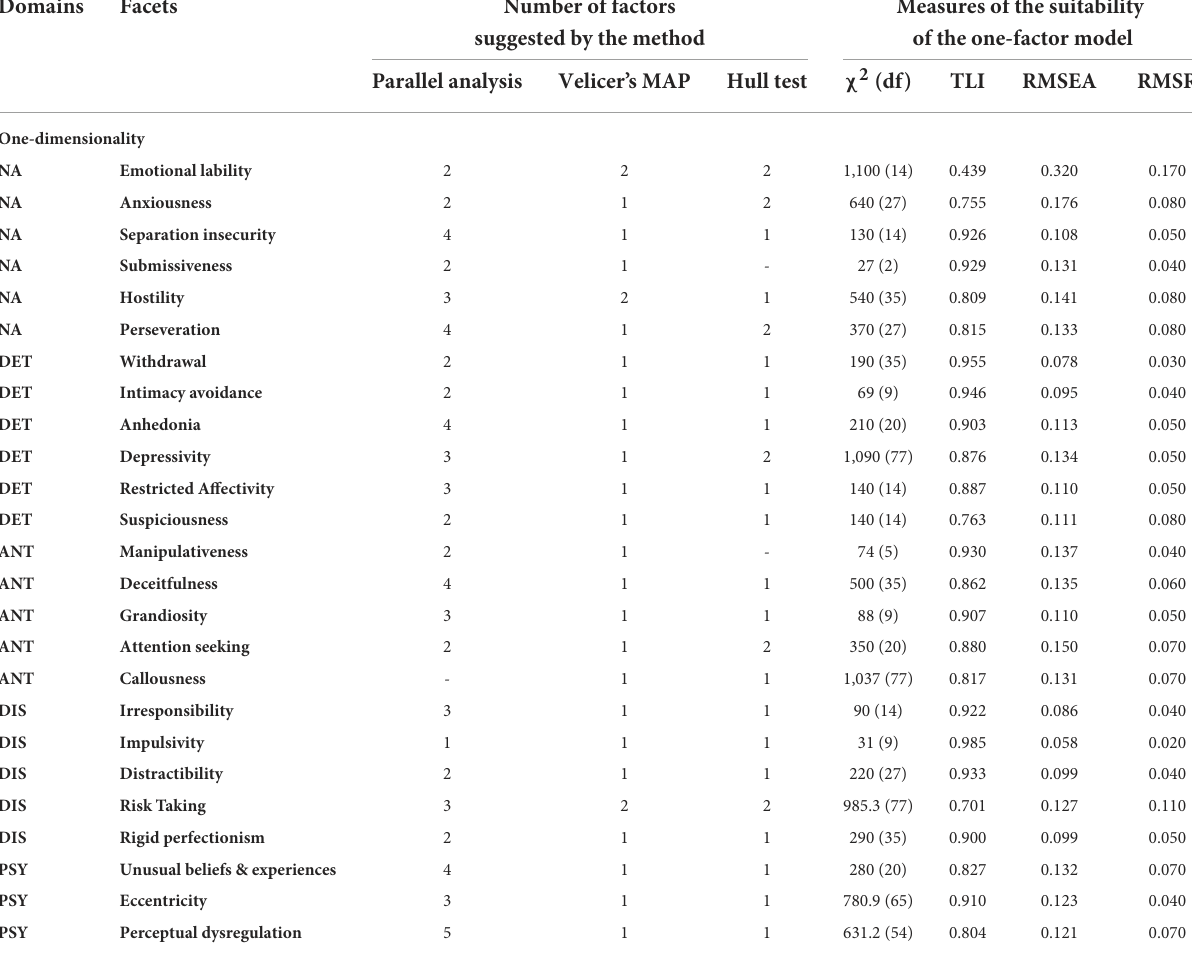
TABLE 3 Unidimensionality analysis of PID-5 (paper-and-pencil) facets according to different methods ( N = 730). Domains